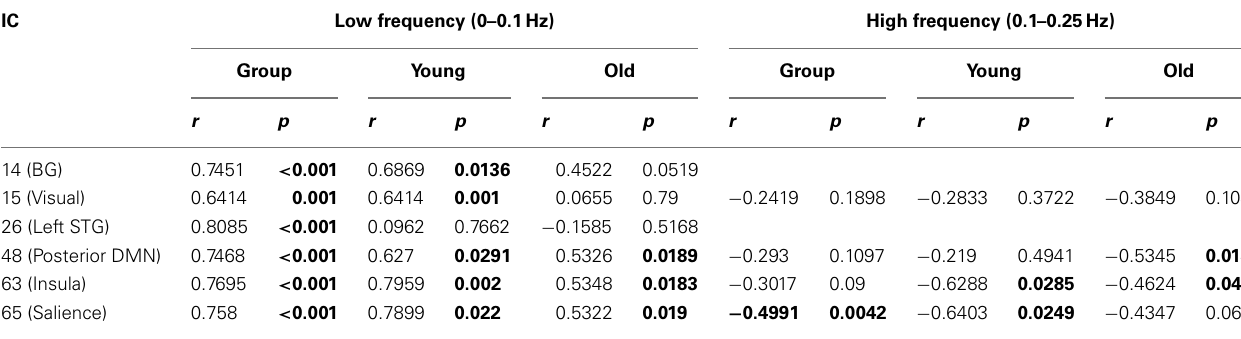
Table 3 | Partial Correlations between BOLD frequency power and task performance with age-related variance